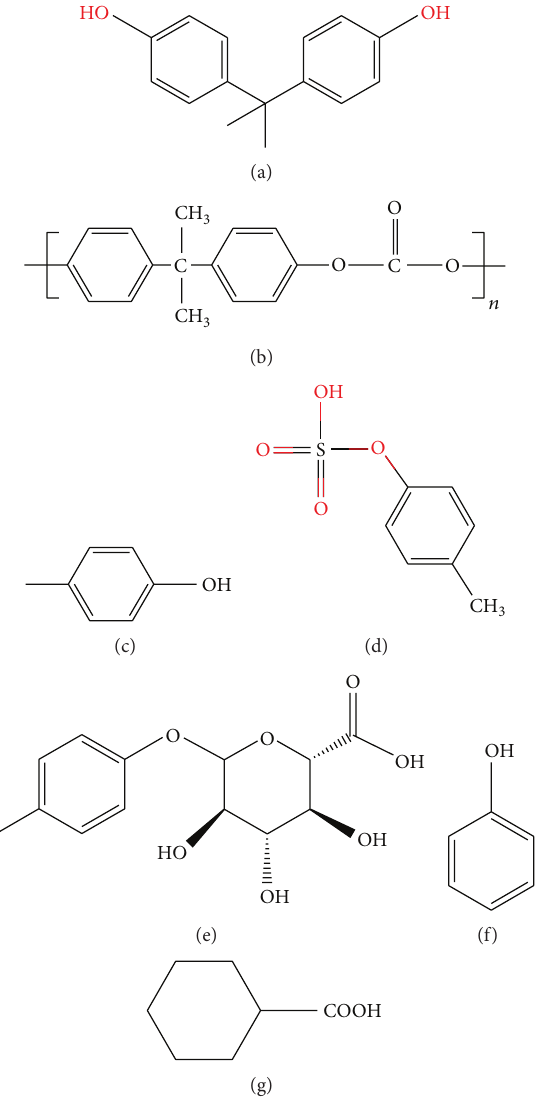
Figure 1: Chemical structures. (a) Bisphenol A (BPA), (b) BPA- containing polycarbonate monomer, (c)p-cresol,(d)p-cresylsulfate (e) p-cresyl sulfate glucuronide, (f) phenol, and (g) phenylacetic